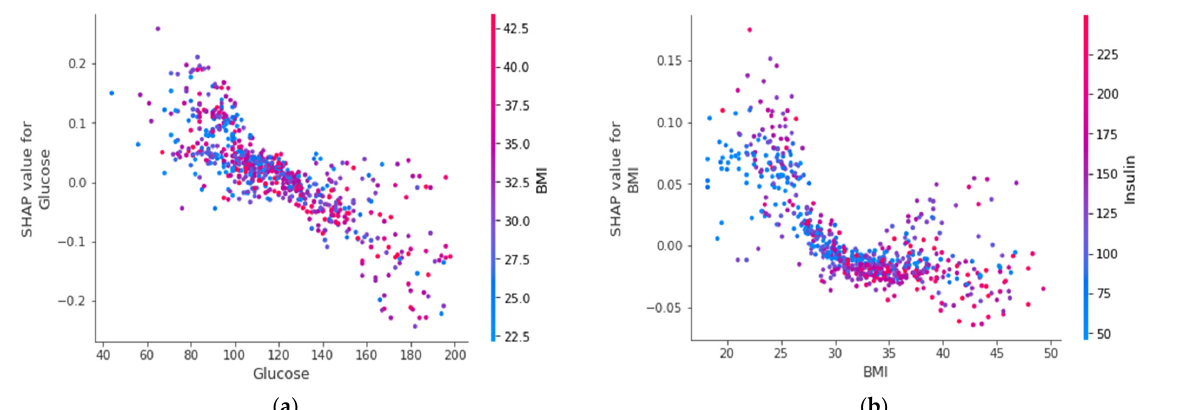
Figure 13. Violin distribution of ( a ) ANN, ( b ) SVM, ( c ) LR, ( d ) RF, ( e ) ADA, ( f ) XGB, and ( g ) Voting classifier.